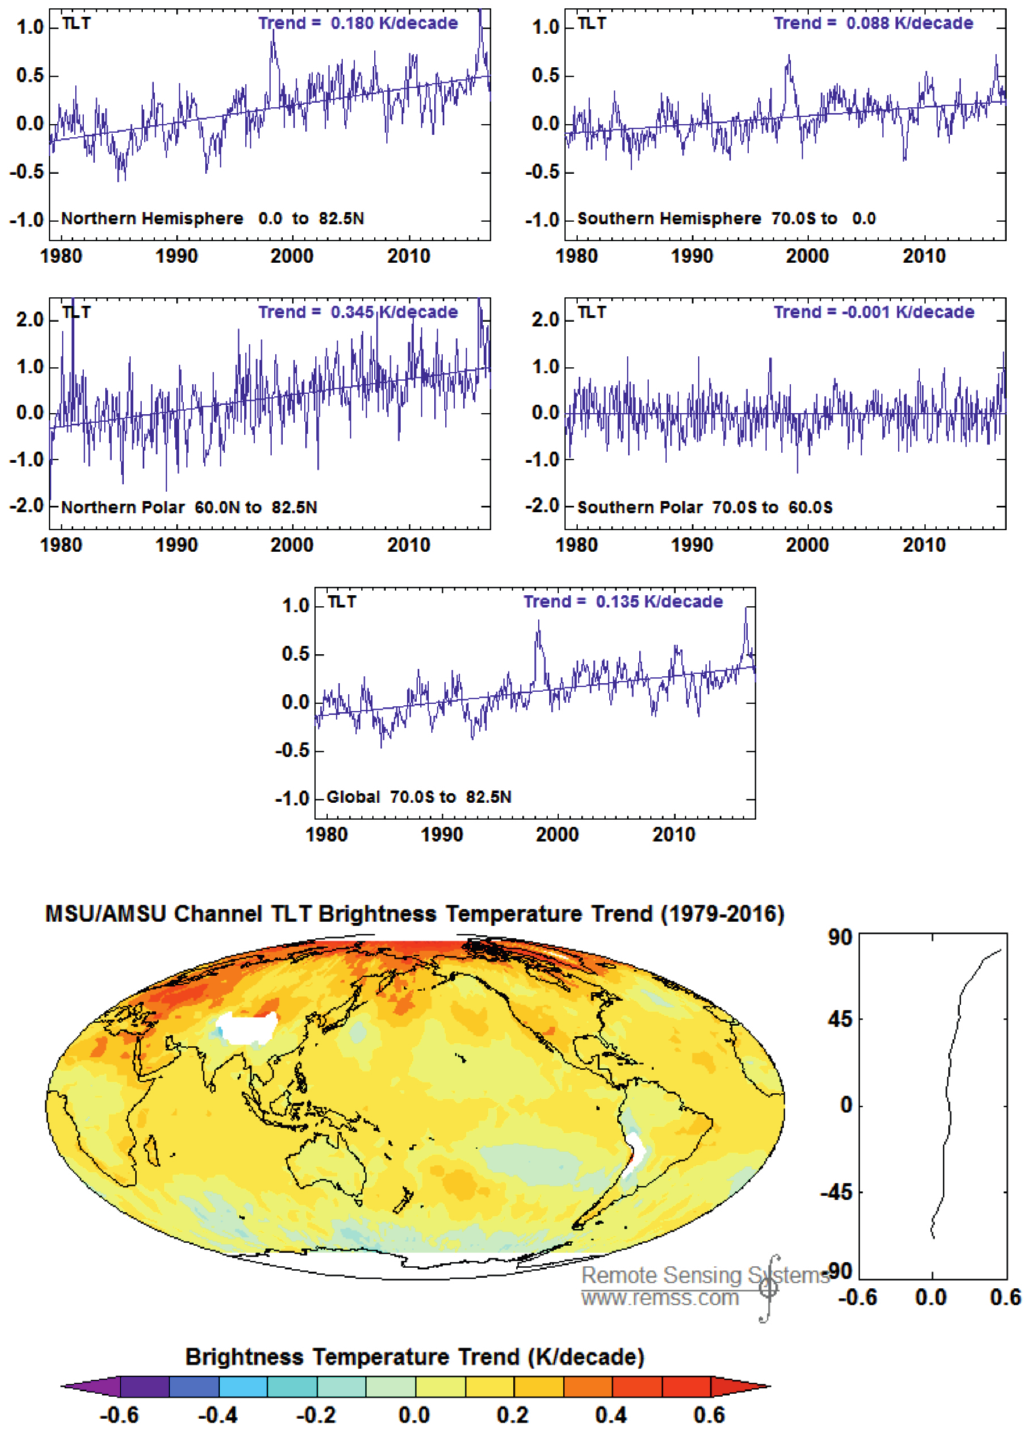
Fig. 7. Satellite temperatures since 1979 (global, northern and southern hemisphere, northern and southern polar). Images from RSS (2017). Warming of northern and southern hemispheres is